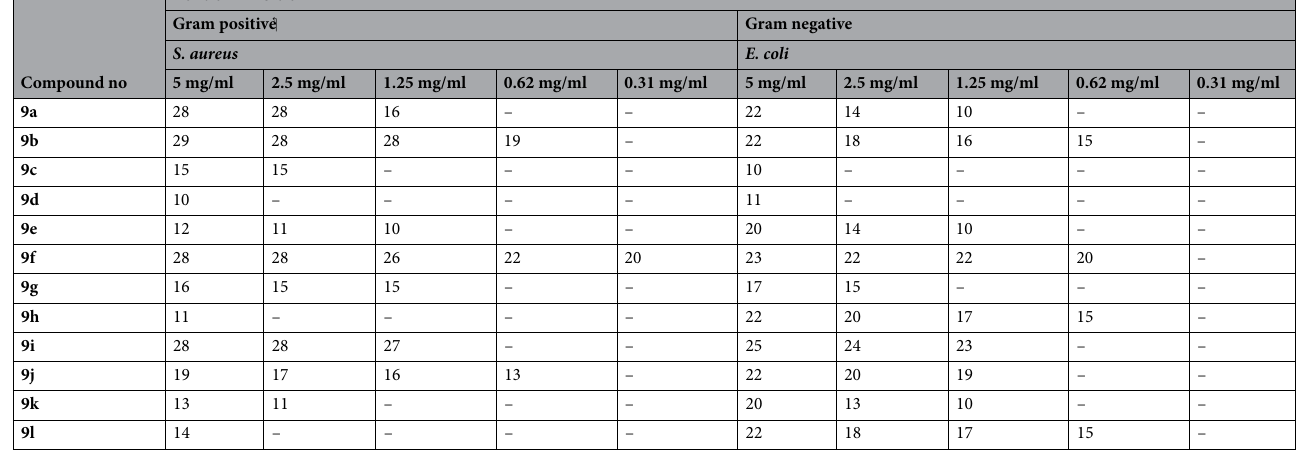
Table 3. Antimicrobial activities of the coumarin 3-carbamide sulfonamides against the pathological organisms based on agar diffusion method. a Mean zone of inhibition in mm beyond well diameter (6 mm) produced on a range of clinically pathogenic microorganisms.